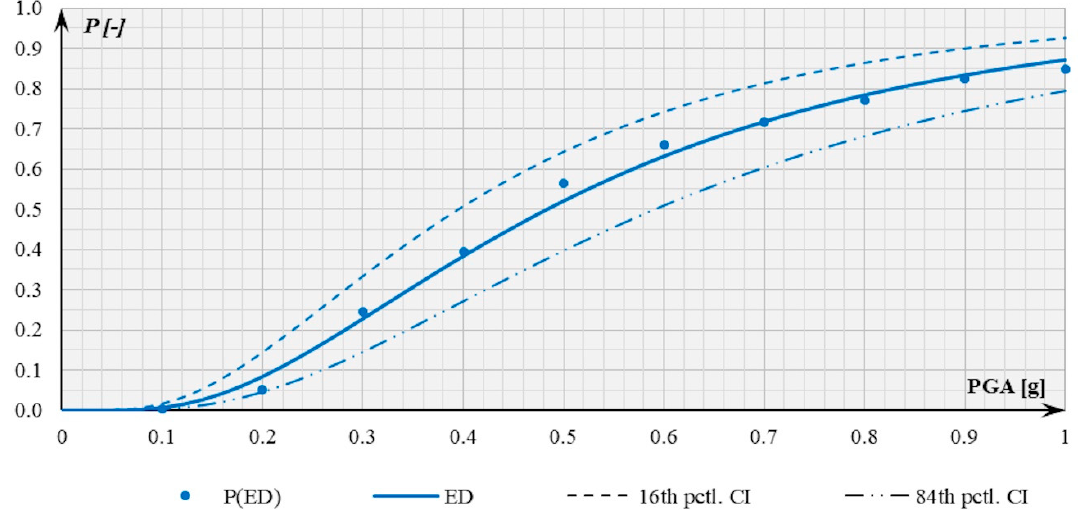
Figure 17. Fragility curve for ED according to HAZUS [32] and its upper and lower confidence interval boundaries.